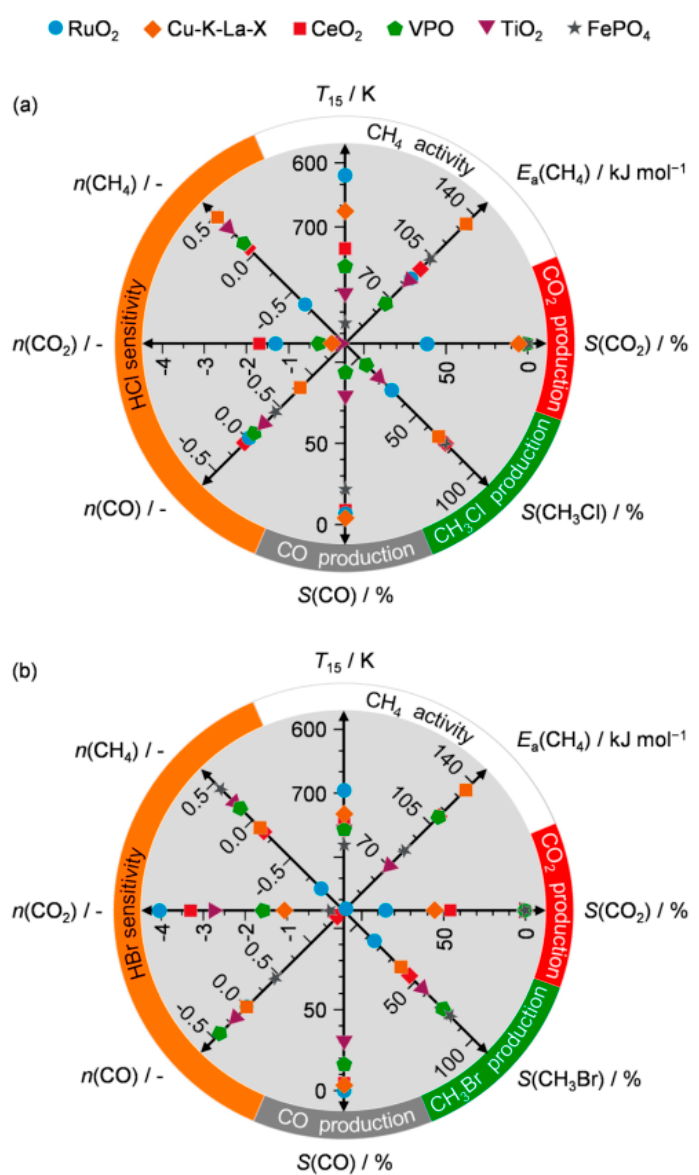
Figure 3. Overview of the catalytic descriptors in ( a ) methane oxychlorination and ( b ) methane oxybromination. The upper half of the radar charts classifies a material as a good oxyhalogenation catalyst if it combines high activity and low propensity to CO 2 formation. The bottom half classifies materials for their ability to produce CH 3 X. Reprinted from [61].